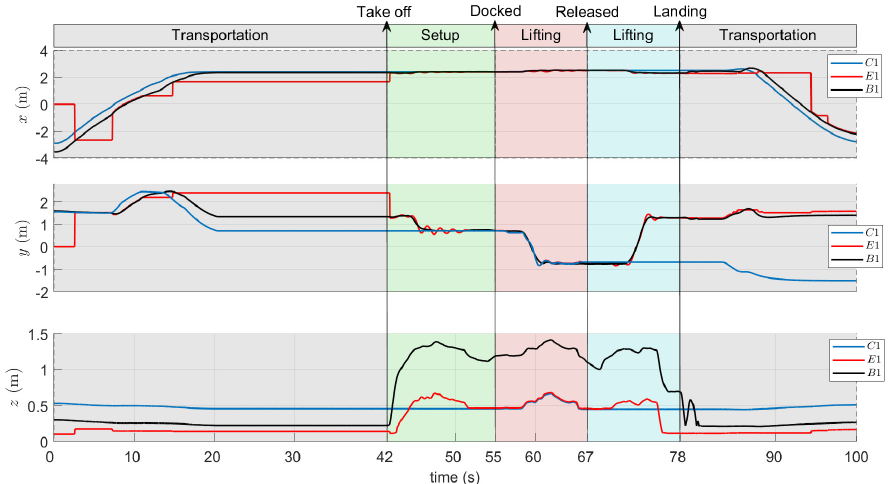
Figure 11. Results of Experiment #1. Position time evolution of the cargo (C1), the electromagnet effector (E1), and the Bebop UAV